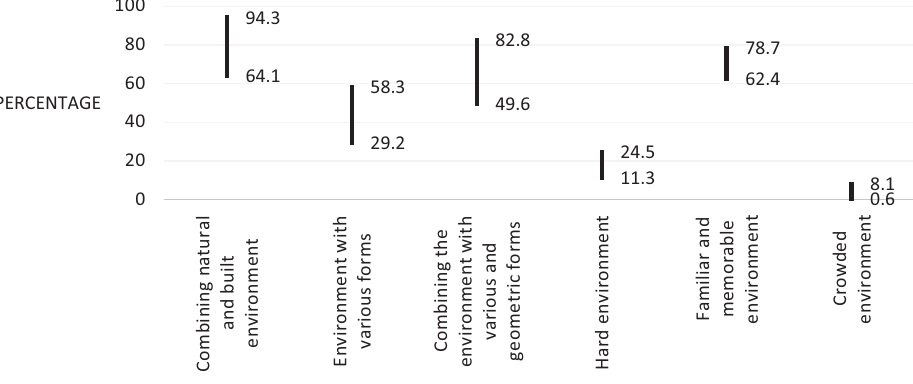
Table 1. Pleasure domain of different environments from the point of view of the audience 62 different residential